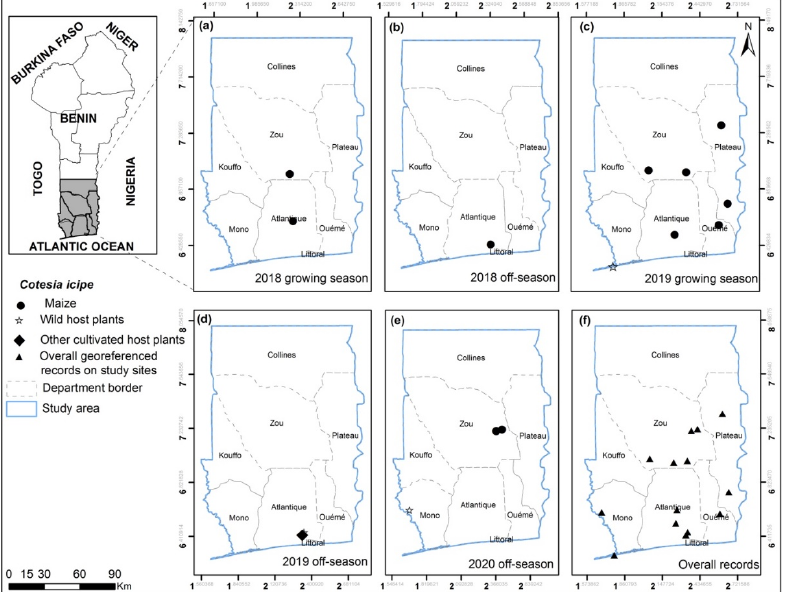
Figure 7. Cotesia icipe georeferenced records on maize, wild and other cultivated host plants for the years 2018, 2019 and 2020 on the study sites for growing ( a , c ) and off-seasons ( b , d , e ) in southern and central Benin ( f ).